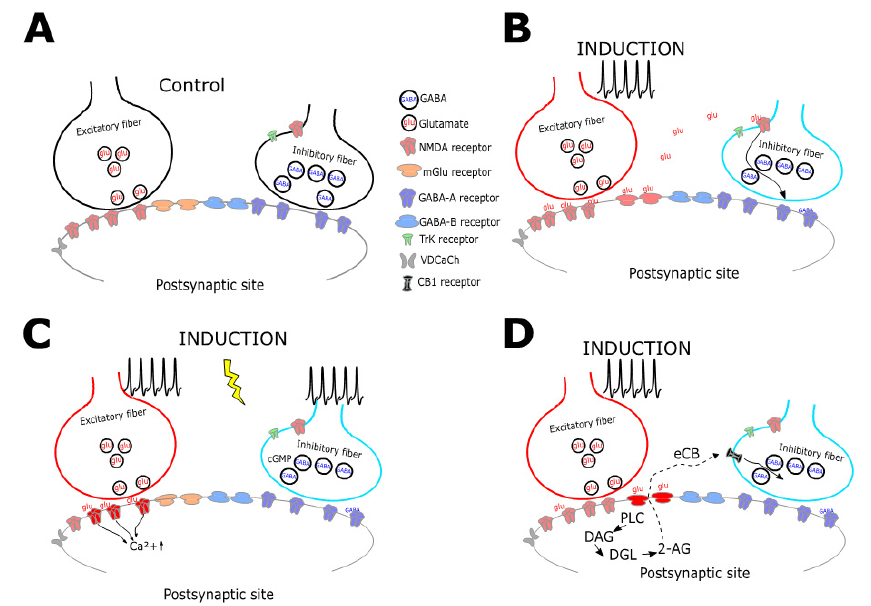
Figure 2. Schematic diagram collecting mechanisms underlying presynaptic LTD. A. Excitatory and inhibitory fibers contact, by releasing glutamate (glu) and GABA (GABA), a postsynaptic neuron expressing both ionotropic (mglu) and metabotropic receptors (GABA-B). B The di ff usion of glutamate in the extrasynaptic space can directly activate presynaptic NMDA-Rs inducing the depression of GABA release. C. The coactivation of glutamatergic and GABAergic ionotropic receptors by simultaneous stimulation of excitatory and inhibitory fibers can lead to the depression of GABA release via a not well-identified mechanism. D. The activation of metabotropic glutamate receptors following repetitive excitatory stimulation triggers intracellular signal cascade, typically involving Phospholipase-C (PLC), diacylglycerol (DAG), Diacylglycerol lipase (DGL) and the 2-Arachidonoylglycerol (2-AG) endocannabinoid (eCB). This class of molecules can freely di ff use in the extracellular space acting as a retrograde messenger to activate specific cannabinoid receptors (CB) onto the GABAergic terminal that trigger the depression of vesicles release via di ff erent pathways.